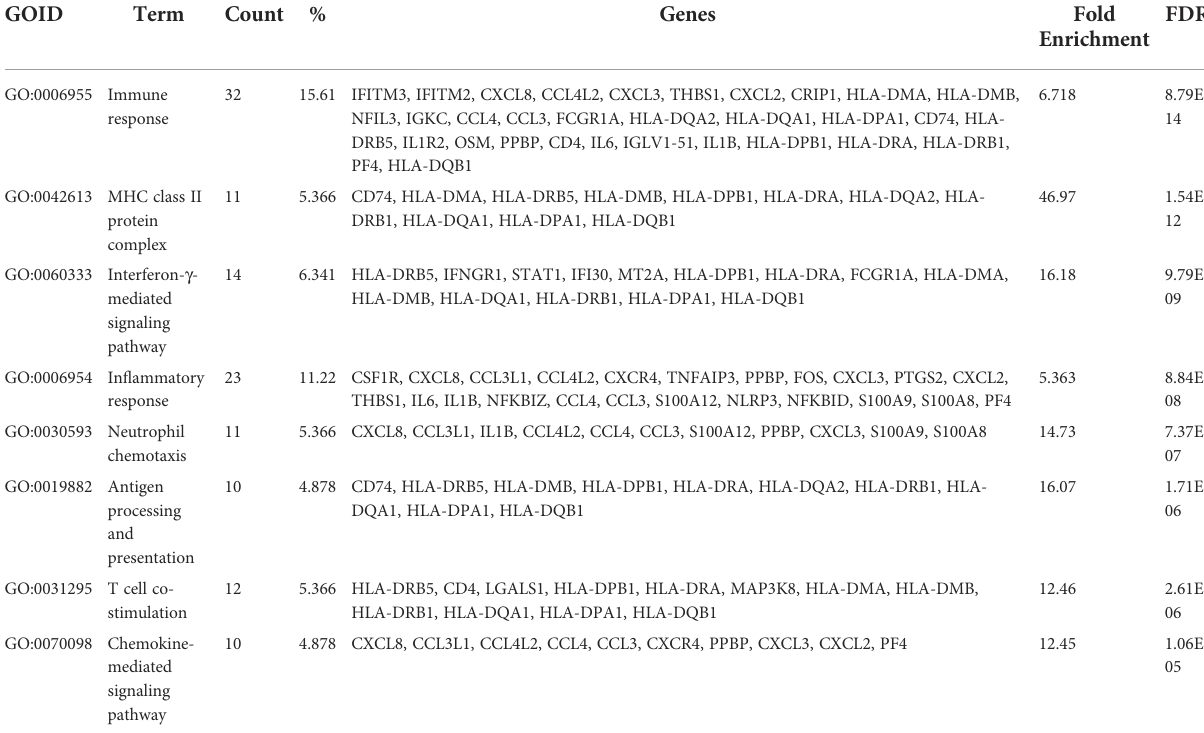
TABLE 1 DAVID enrichment analysis for 219 overlapped DEGs between KD and severe COVID-19. GOID Term Count % Genes Fold